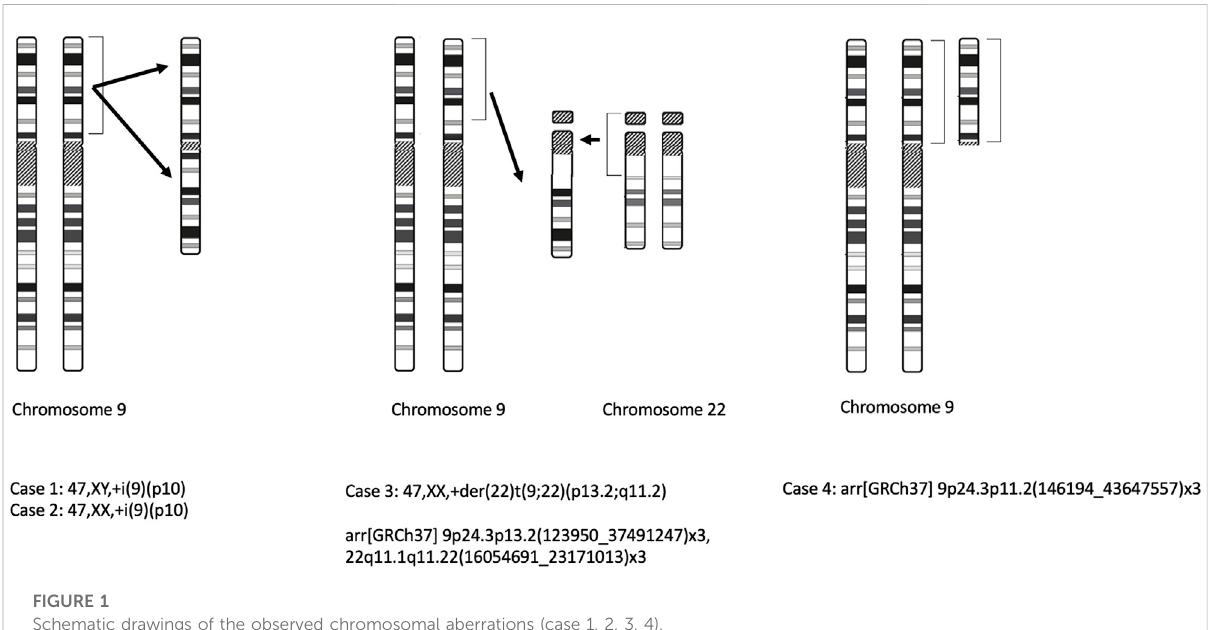
FIGURE 1 Schematic drawings of the observed chromosomal aberrations (case 1, 2, 3,